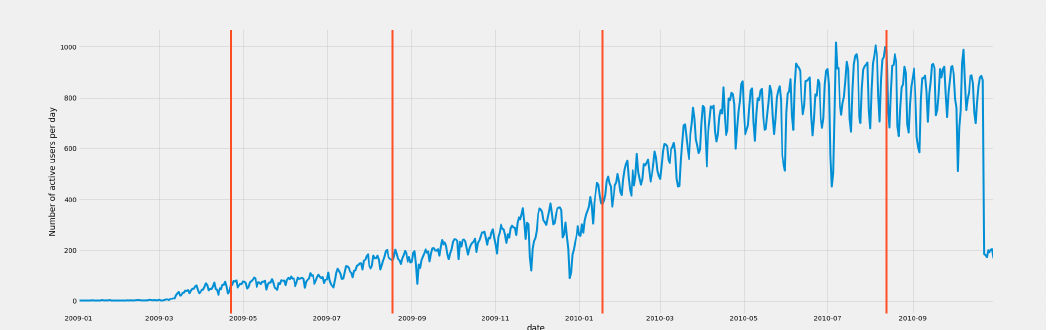
Figure 2. Evolution of the number of active users per day on Foursquare in a two-year period in Manhattan (New York City). Vertical red lines represent breakout points in the time series calculated with the E-Divisive with Median (EDM) algorithm